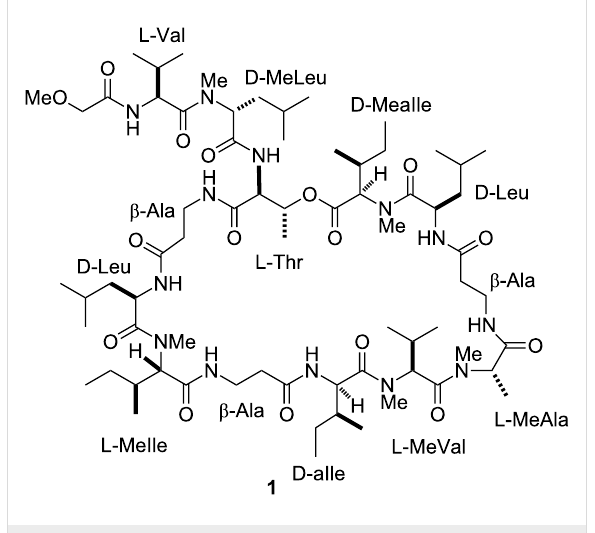
Figure 1: Structure of the known compound theonellapeptolide Id ( 1